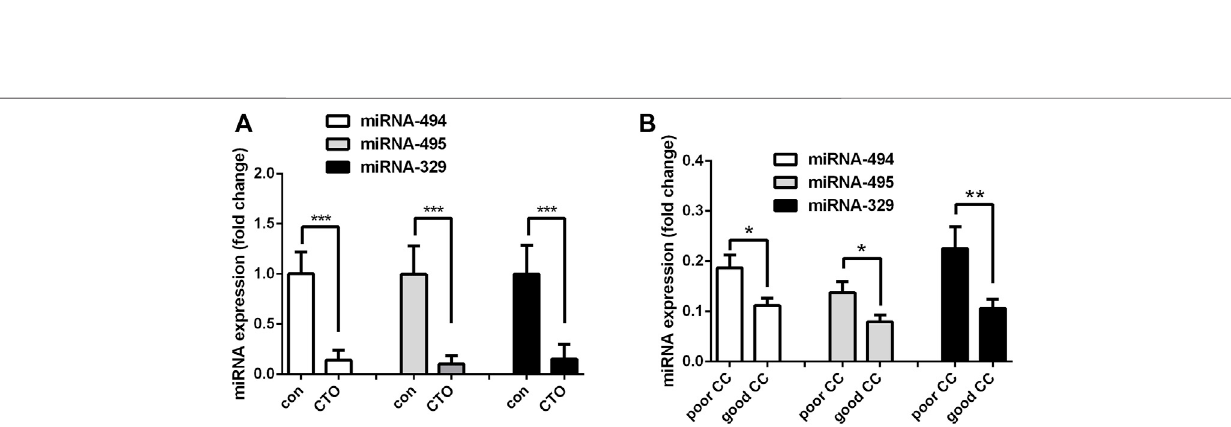
FIGURE 3 | Expression of miR-494, miR-495 and miR-329 in another patient cohort. (A) , Expressions of these miRNAs in patients with coronary artery disease (controlgroup, N =22)andchronictotalocclusions(CTOgroup, N =46). (B) ,PatientsinCTOgroupweredividedintotwosubgroupsaccordingtoCCgrade.Expression levels of miRNA-329, miRNA-494 and miRNA-495 in poor CC group ( N = 17, CC = 0 or 1) and good CC group ( N = 27, CC = 2). * p < 0.05, ** p < 0.01, *** p <